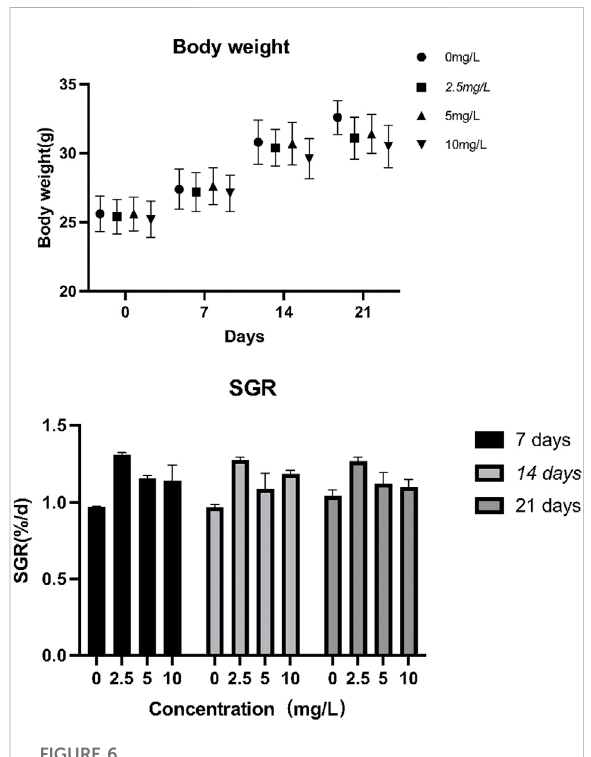
FIGURE 6 The effect of quercetin on the growth performance of Odontobutis potamophila . The bars indicate the mean weight ± SD ( n = 3) of fi sh in the three treatment groups and the control. Statistical signi fi cance was taken as *( p < 0.05) and **( p < 0.01), compared with the